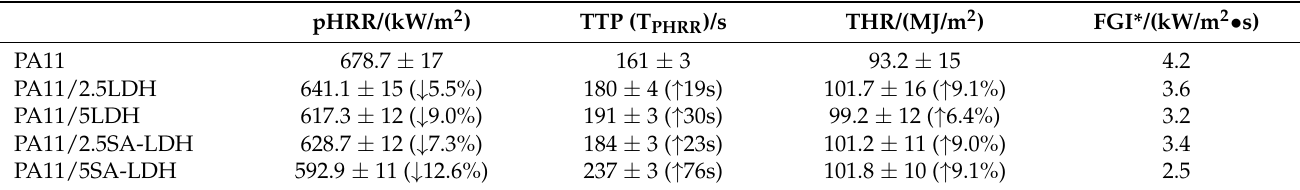
Table 2. LOI and UL-94 results for PA11 and its composites.